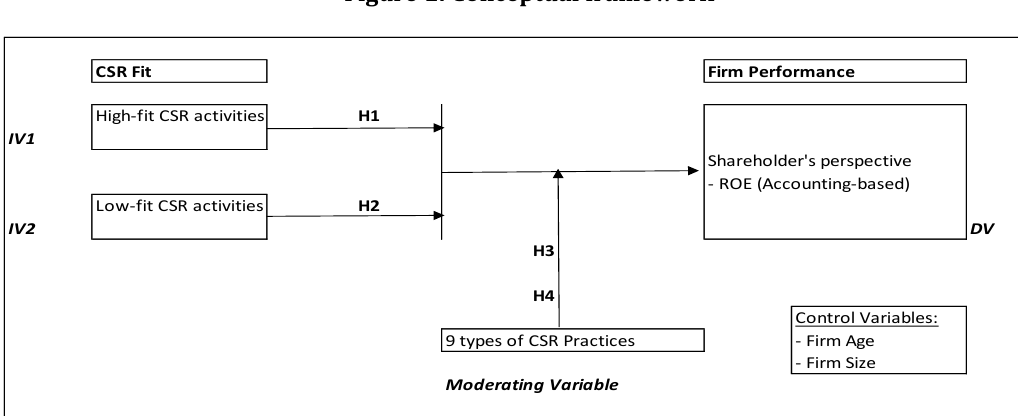
Figure 1: Conceptual